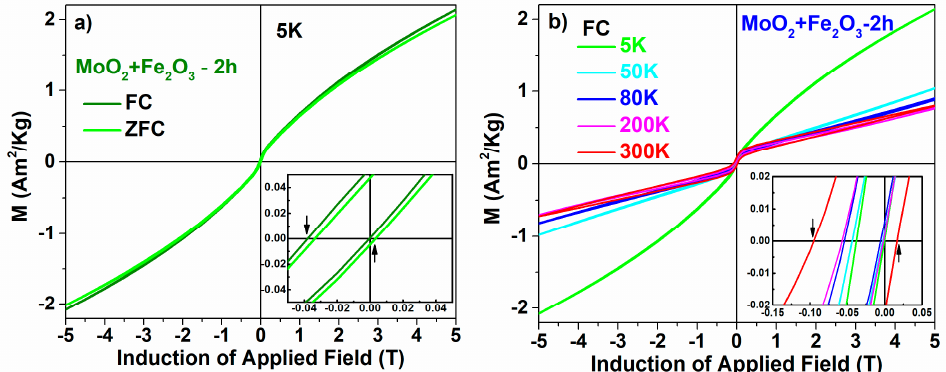
Figure 4. Hysteresis curves for the sample after milling for 2 h ( a ) at 5 K measured on ZFC and FC, and ( b ) measured at different temperatures on FC. Insets: zoomed view of coercivity.